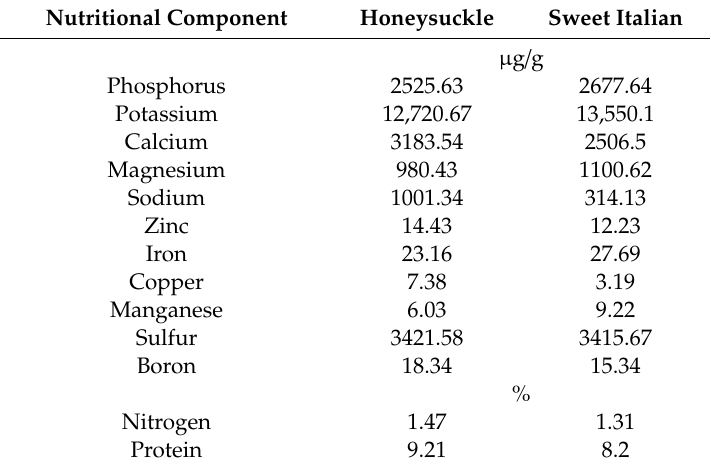
Table 1. The nutritional component of the red onions from two cultivars. Nutritional